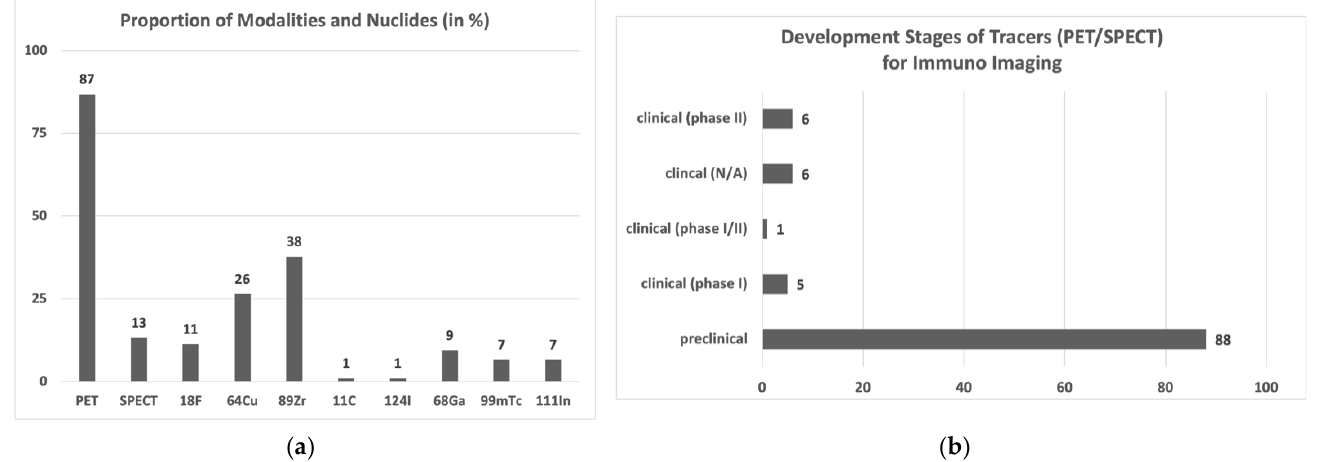
Figure 2. Data analyses of published immuno-imaging reagents (PET/SPECT) ( a ) Proportions of PET vs. SPECT tracers and the applied nuclides in the screened literature. ( b ) Overview of development stages of the published PET/SPECT tracers. Tracers that advanced to clinical stage were not included in ‘preclinical’. Tracers that are tested in different clinical studies (for different tumors, in comparative studies, and in different phases) were counted only once in the most progressed phase.